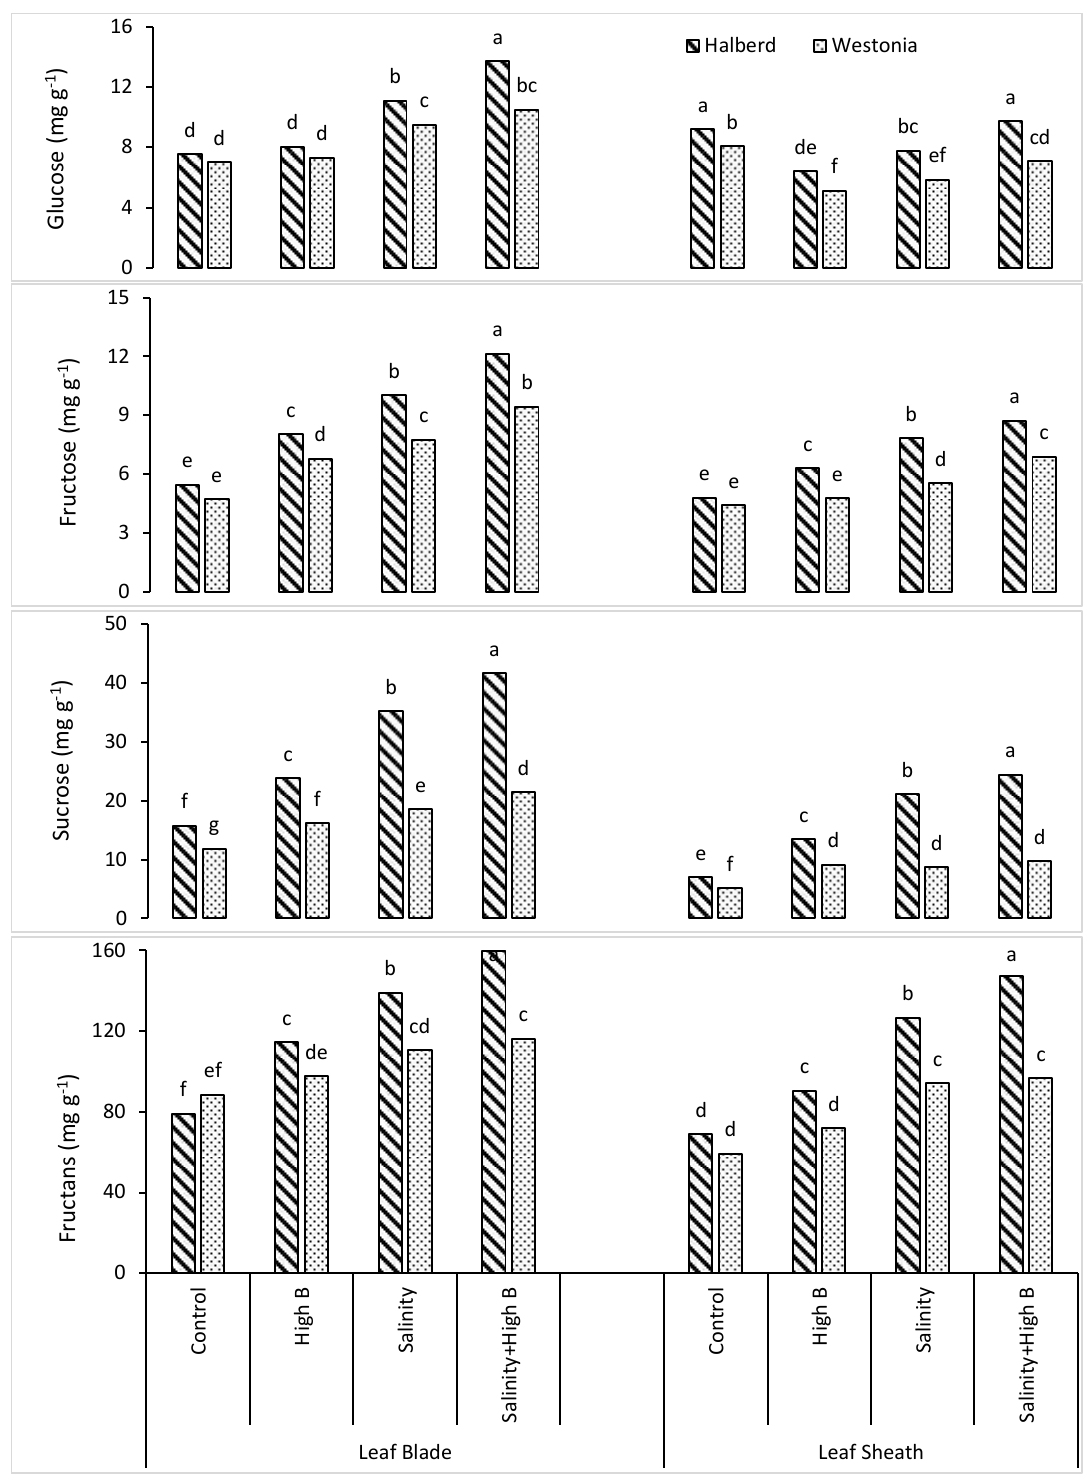
Figure 2. Impact of soil salinity and high B on glucose, fructose, sucrose, and fructans (mg g − 1 ) partitioning in wheat leaf (each value is a mean, n = 3 statistically significant at p ≤ 0.05, T bars represent ± standard error of means). Whereas, T 1 = control, T 2 = B at 7.5 mg kg − 1 (high B), T 3 = 15 EC dS m − 1 (salinity), and T 4 = 15 EC dS m − 1 + B at 7.5 mg kg − 1 (salinity + high B). Haldberd (HB), Westonia (WS).